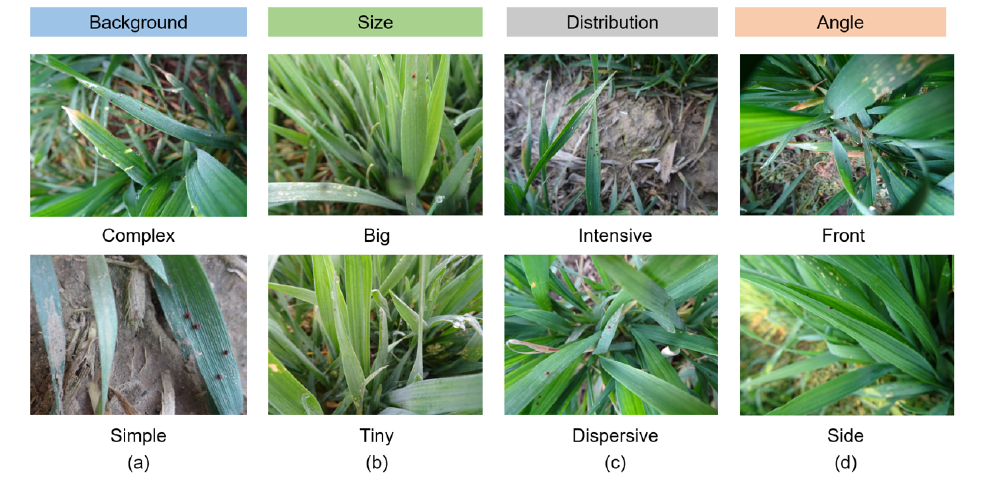
Figure 1. Images of wheat spider mites taken under different shooting conditions: ( a ) different backgrounds; ( b ) different sizes; ( c ) different distributions; ( d ) different